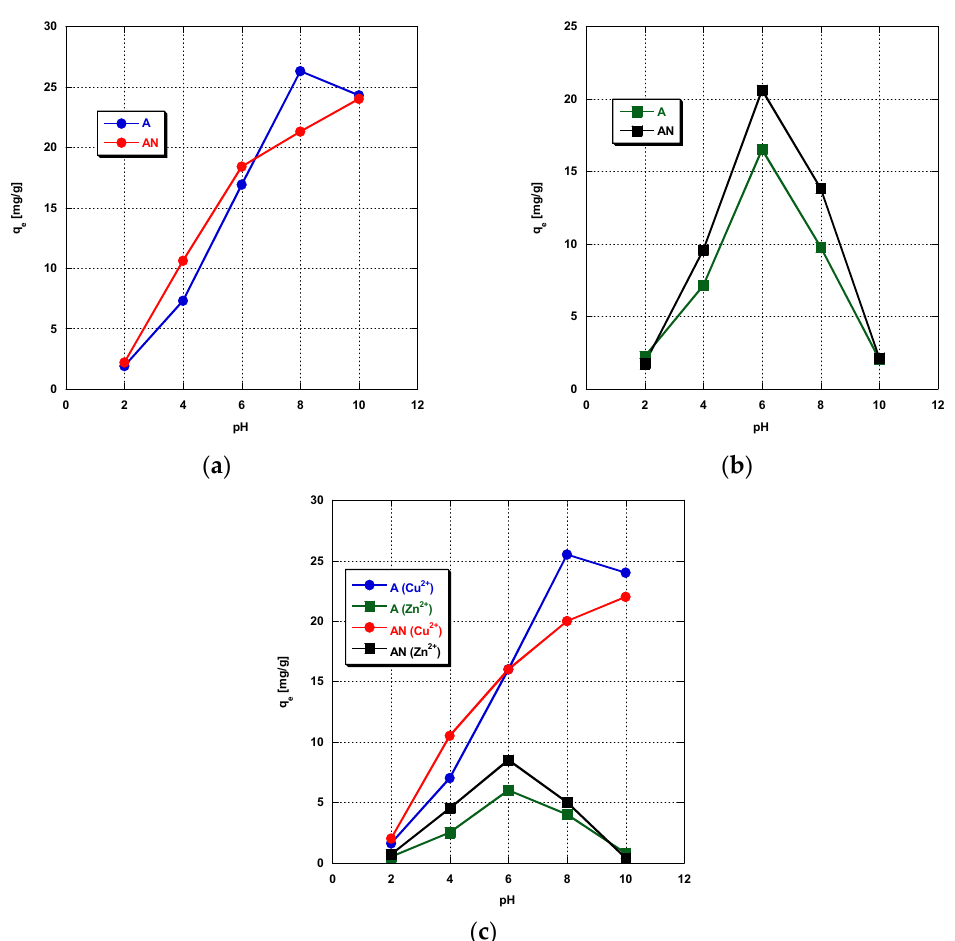
Figure 2. The effect of the solution pH on ( a ) Cu(II) ions’ adsorption, ( b ) Zn(II) ions’ adsorption, and ( c ) simultaneous adsorption of Zn(II) and Cu(II) (mass of sorbent: 0.01 g, heavy metal ions’ concentration: 10 mg/L, time 240 min, shaking speed 180 rpm, temperature: 22 ± 2 °C). Changes in pH of the solution also affect the nature of charge on the adsorbent